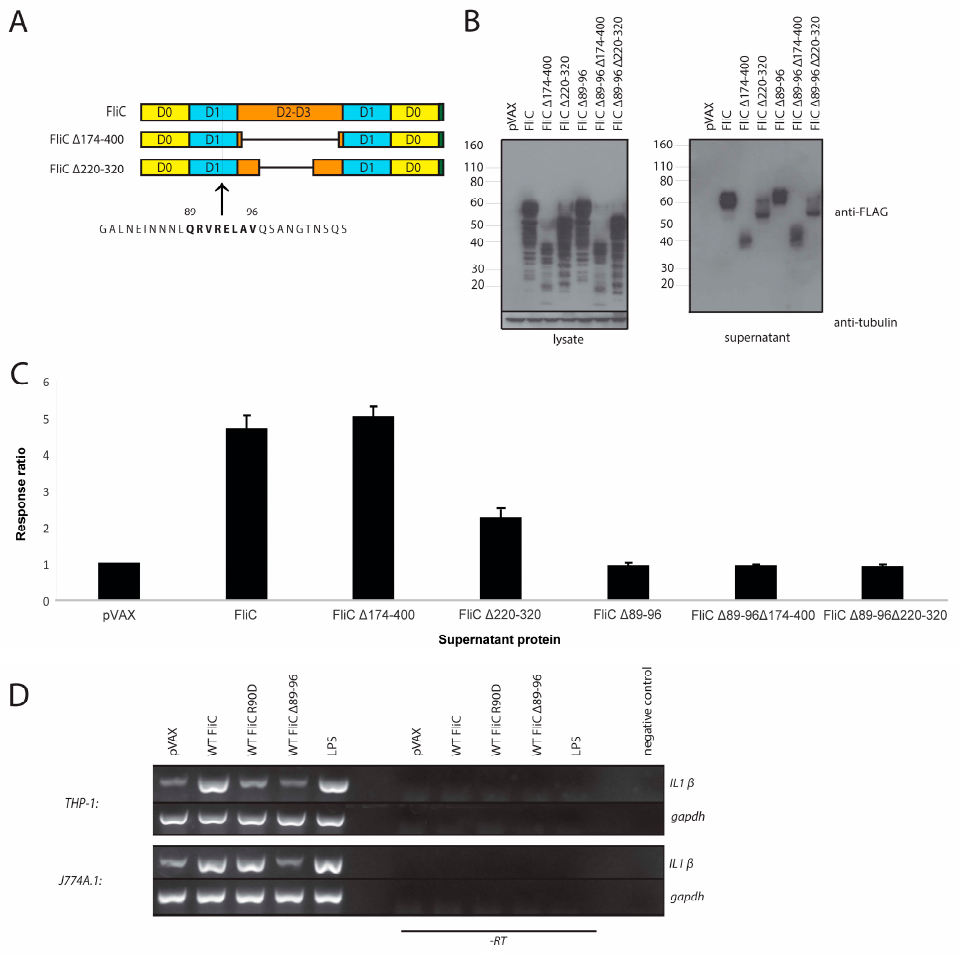
Figure 3. Residues QRVRELAV (89–96) of FliC are required for TLR5 agonist activity. ( A ) Schematic representation of FliC constructs; ( B ) Western blots of cell lysates and supernatants from transiently transfected 293T. Cells were transfected with pVAX, FliC, FliC Δ 174–400, FliC Δ 220–320, FliC Δ 89–96, FliC Δ 89–96 Δ 174–400 or FliC Δ 89–96 Δ 220–320. Blots were probed with a mouse anti-FLAG tag